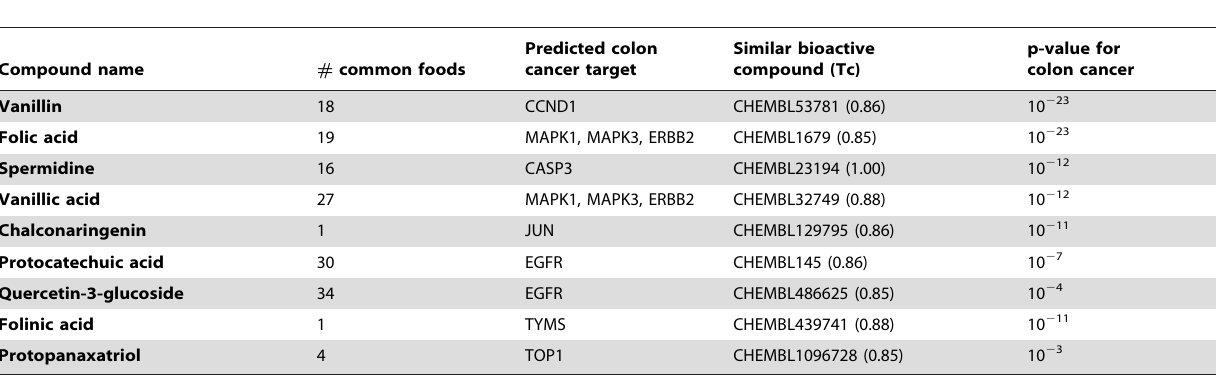
Table 2. Phytochemicals (column 1) from common foods (column 2) with inferred activity to a colon cancer protein (column 3), based on structural similarity with an active compound from the ChEMBL library (column 4).